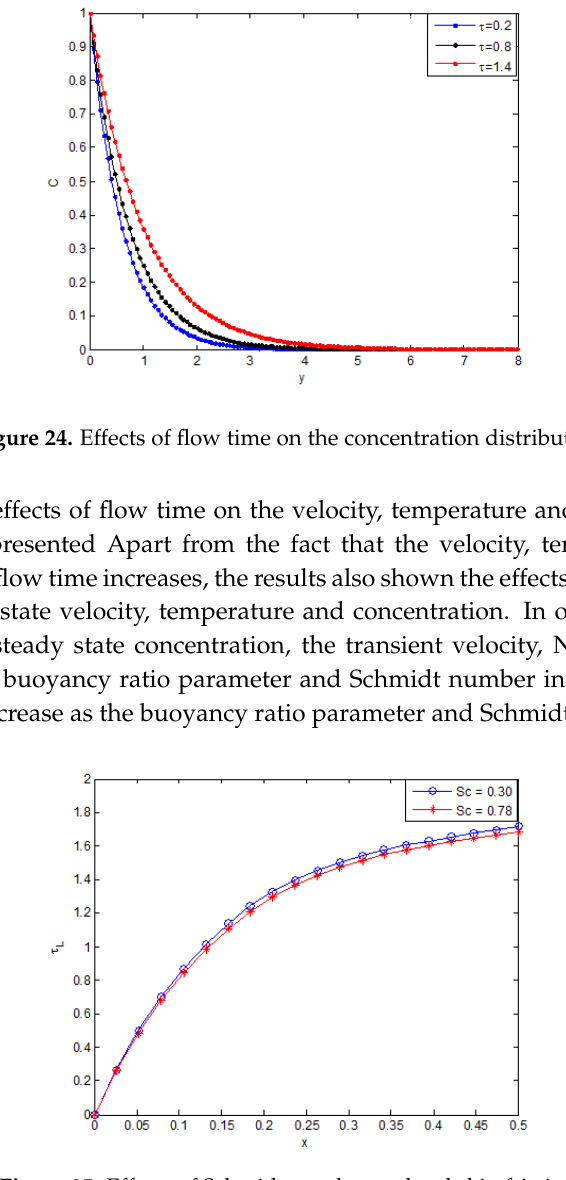
Figure 25. Effects of Schmidt number on local skin